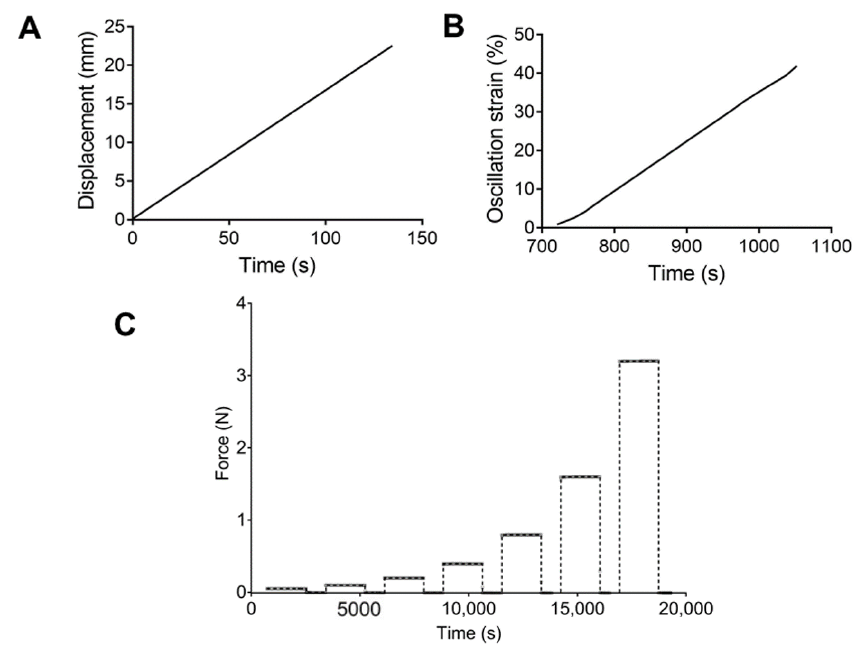
Figure 1. Schematic representation of the ( A ) tensile test, ( B ) strain sweep, and ( C ) cycles of forces applied for the creep test.